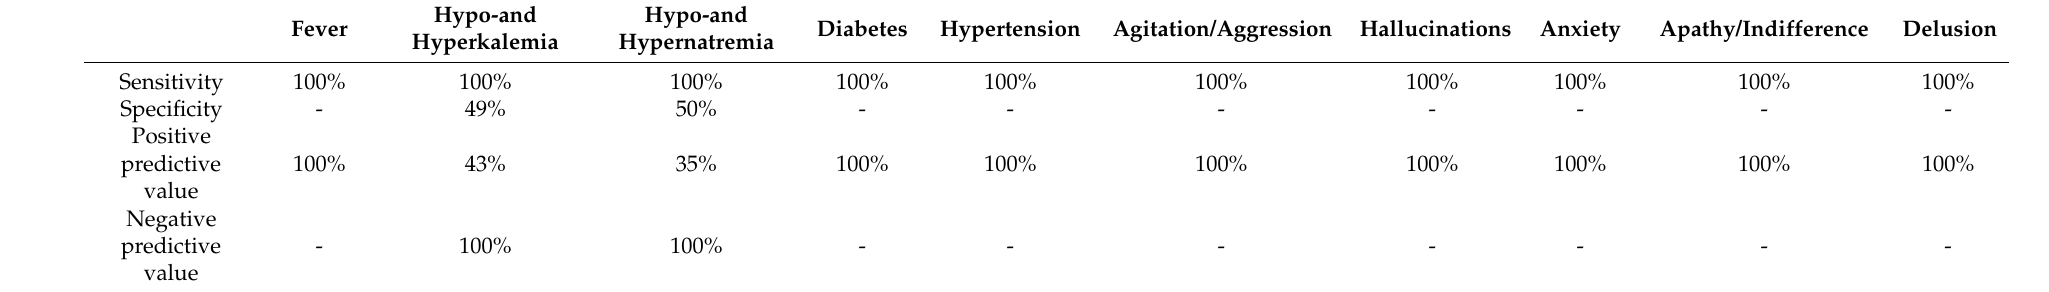
Table 7. Sensitivity, specificity, and positive and negative predictive values for alerts from the MyPredi™ remote monitoring